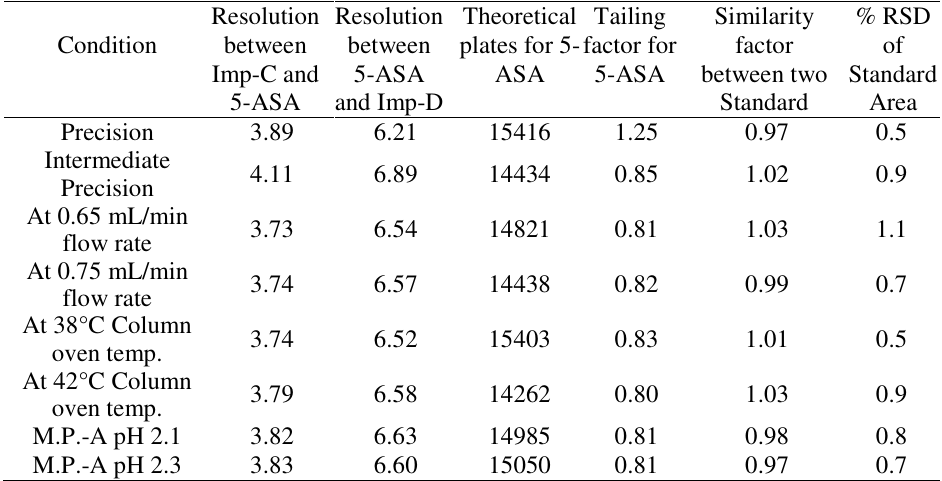
Figure 2. Overlay chromatograms of replicate standard injections Table 3 . System suitability results (precision, intermediate precision and